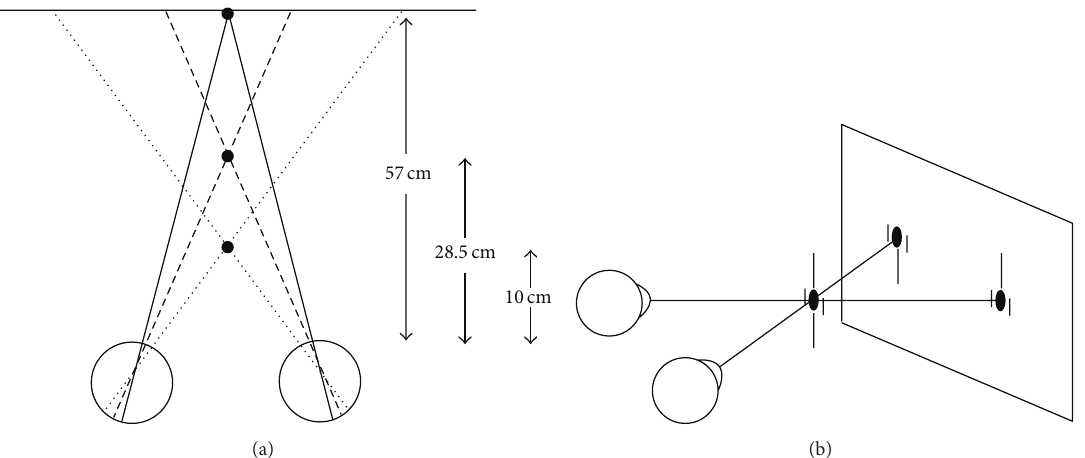
Figure 6: Illustration of the three vergence conditions in Experiment 1. Observers “free-fused” the fixation stimulus for the 28.5 and 10 cm distances. (a) Top view and (b) oblique view for one of the free-fused stimuli.